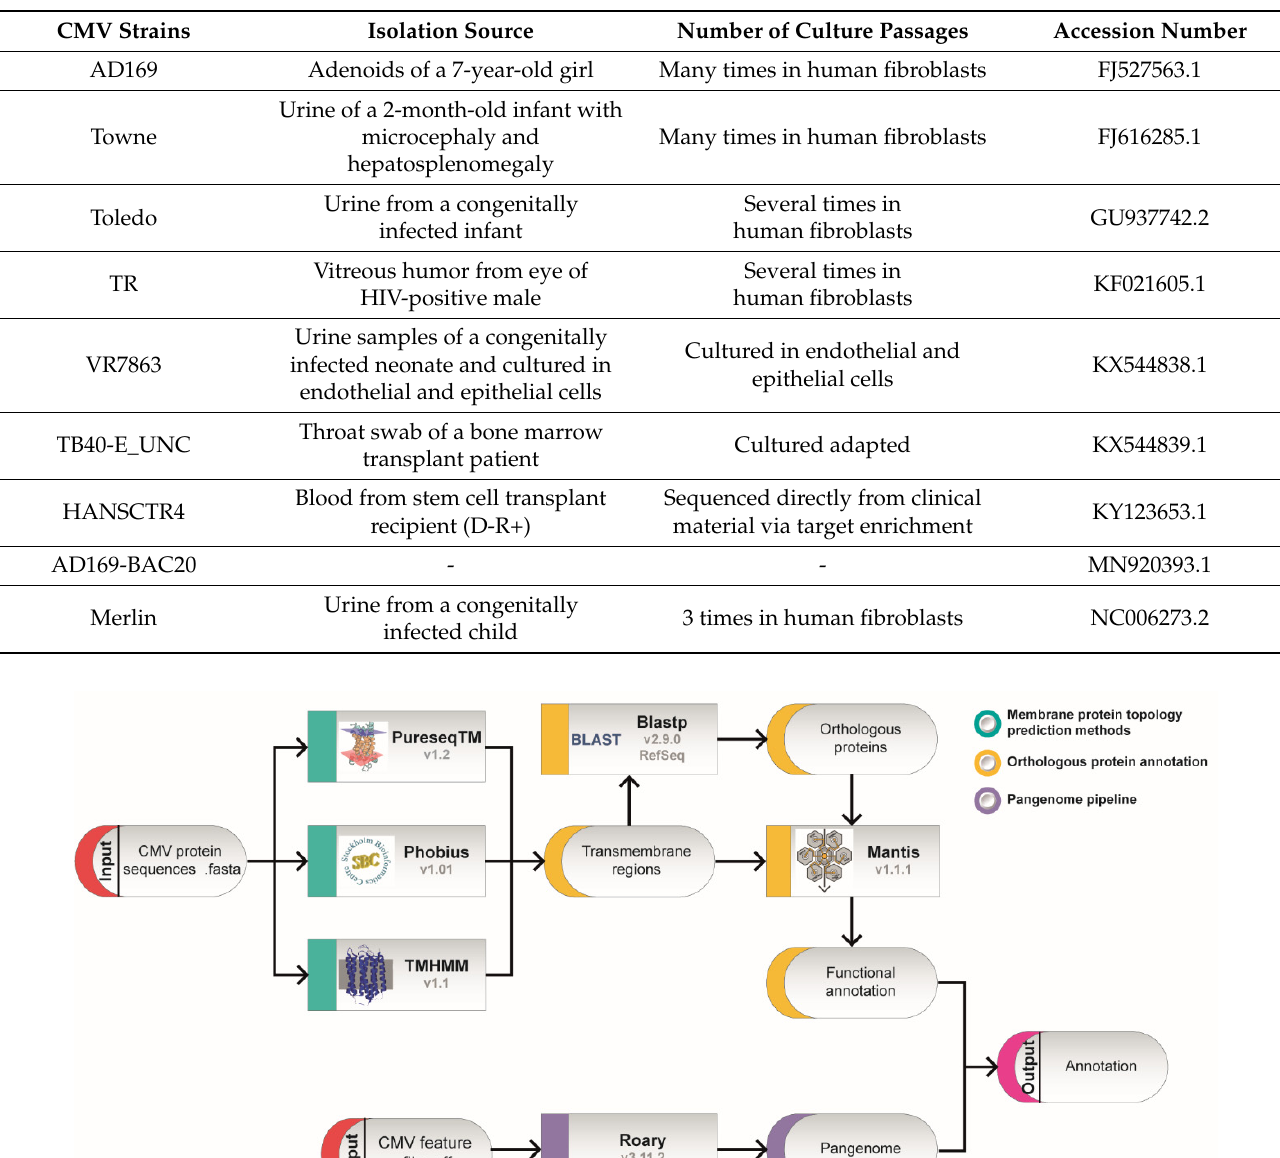
Table 1. Characteristics of CMV strains used in this study and their corresponding accession number at nucleotide database.